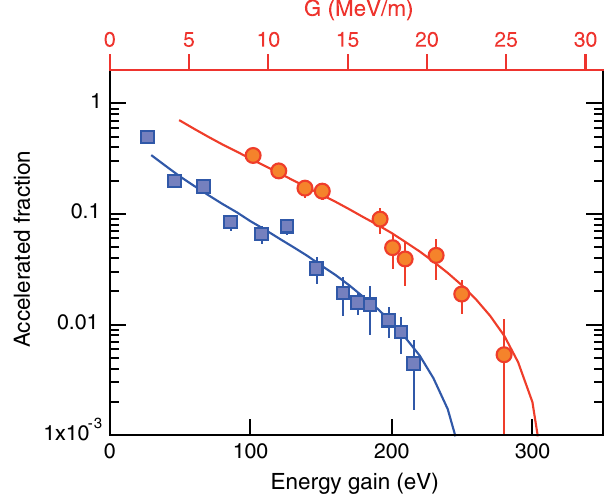
FIG. 10 (color online). Measurement of the accelerated fraction as a function of energy gain (bottom axis) and acceleration gradient (top axis) for two different laser peak electric fields ¼ 2 . 85 GV = m (orange circles), E ¼ 2 . 36 GV = m (blue [ E p p squares)]. We measure a maximum energy gain of 280 eV corresponding to a maximum acceleration gradient of 25 MeV = m. The curves represent simulation results, which were ¼ 77 nm. obtained according to Eq. (8) for z 0 ¼ 120 nm and w e The overall amplitude of the simulated values has been scaled to fit the experimental data.